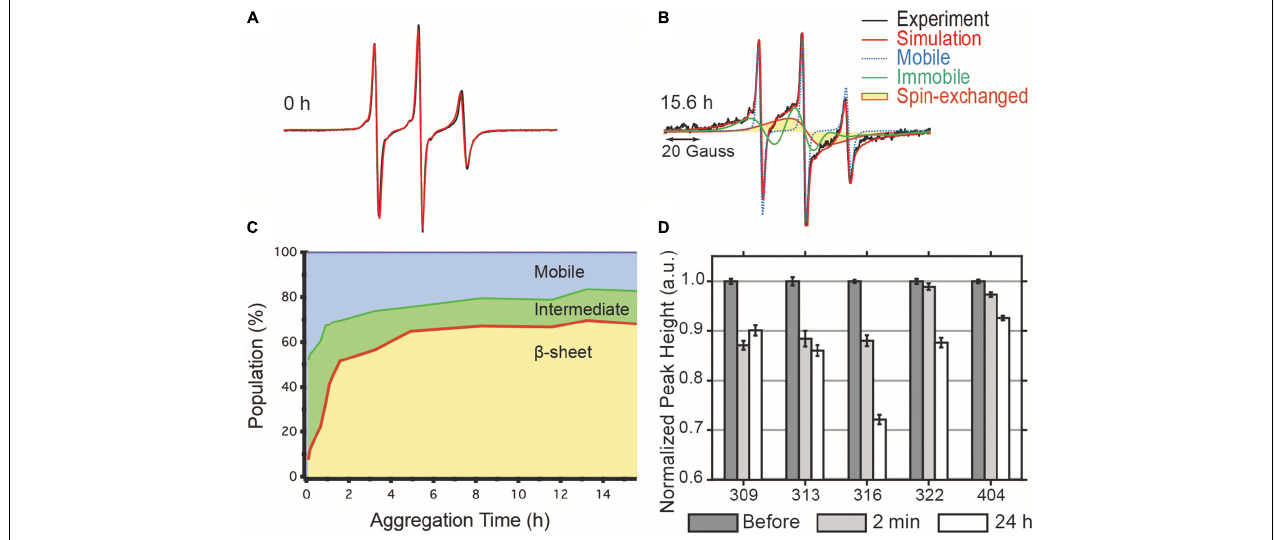
FIGURE 4 | cw-EPR time course of 4:1 tau:heparin molar ratio induced aggregation. (A) Before heparin addition, the EPR line shape (black) can be simulated by a single mobile component (red). (B) 15.6 h after heparin addition, the spectrum is broadened and the simulation requires the addition of an immobile (green) and spin-exchange (yellow) component in order to obtain a good fit. (C) Time evolution of the relative contributions of each component. (D) ESEEM relative deuterium peak normalized by the value before heparin addition and plotted versus MTSL-labeled residue. The decrease in peak height, reflecting a local dehydration, at 2 min shows that the arrangement of the intermediates is consistent with the structural features of matures fibrils. Error bars represent the standard deviation of the baseline